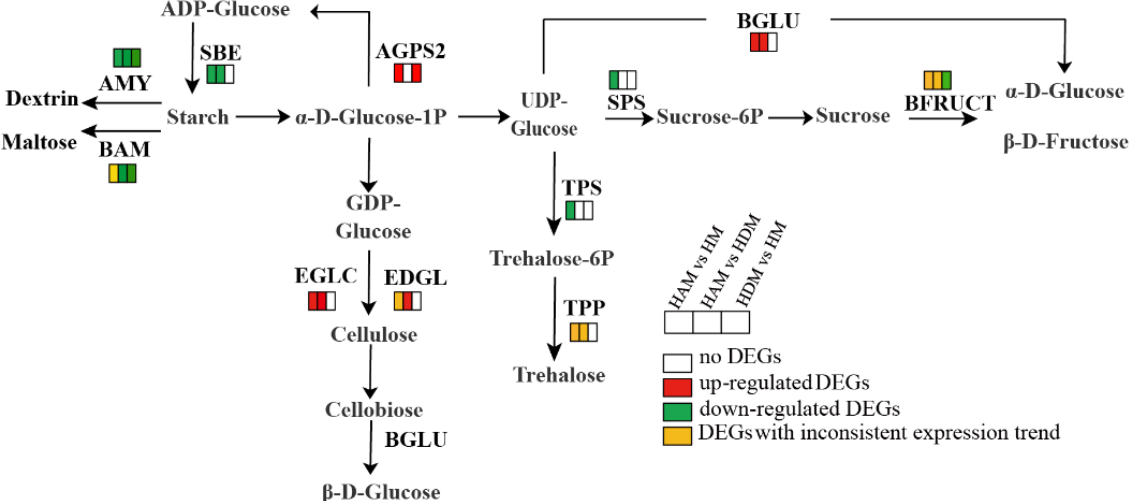
Figure 8. Interstocks induced changes in the expression profiles of the key starch and sugar metabolism. The rectangles behind the gene, which were tagged with red, green, white and yellow color, represent the upregulated DEGs, downregulated DEGs, unchanged DEGs and the DEGs with inconsistent expression trends, respectively.